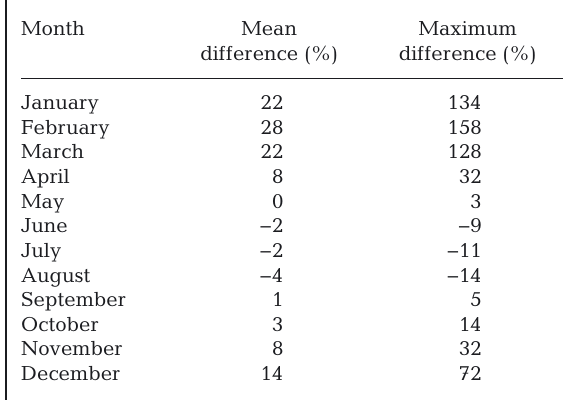
Fig. 8. Relative difference in cal- culated egg hatch rate per adult female salmon louse between where we assume that the salmon reside (Estimate 4) and the current practice of tempera- ture at 3 m depth (Estimate 1). The calculated lice releases are calculated for all approved aqua - culture sites in Norway and are clustered into spatial grids (dis- tance from the coast and geo- graphic latitude of the farm). Red: areas where Estimate 4 in- creased the calculated salmon lice production compared to Es- timate 1; blue: areas with de- creased estimated lice produc- tion by Estimate 4 compared to Estimate 1. The maximum differ- ence in the increased hatch rate was 158%; however, the scale is cut off at 100% to more clearly illustrate the